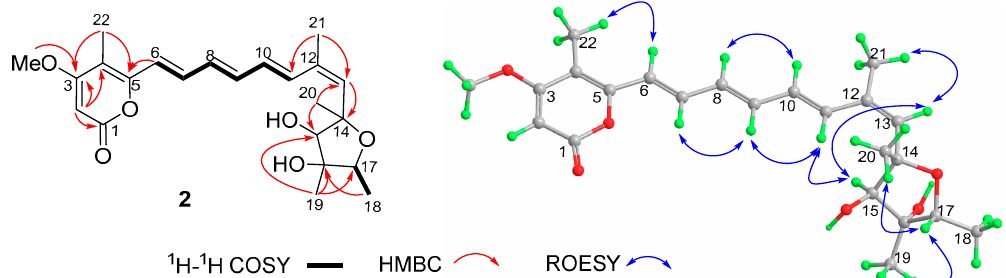
Figure 3. The 1 H– 1 H COSY and the key HMBC and ROESY correlations of 2 .